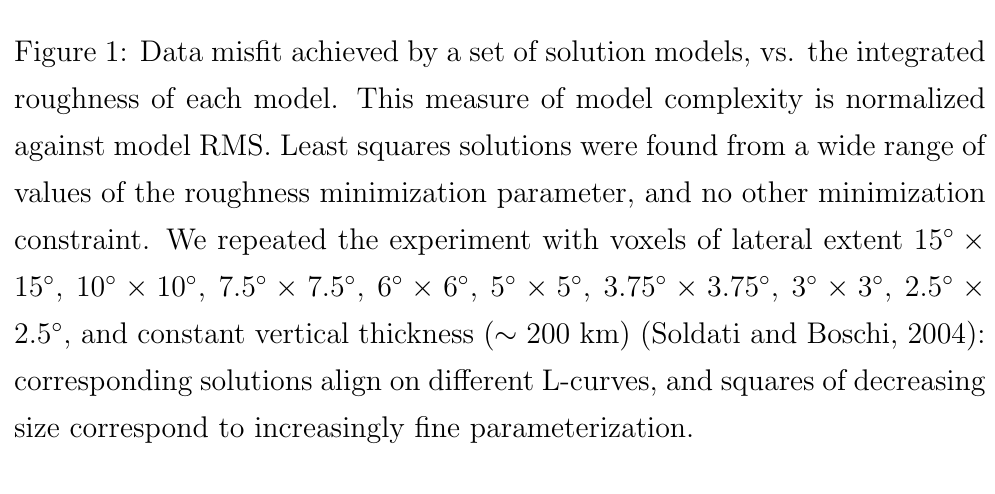
Figure 2: (Top) 24 , 840 × 24 , 840 (5 ◦ -voxel grid) resolution matrix R for the chosen regularization scheme, averaged (Boschi, 2003) so that it can be plotted in this limited space; here, vertical tradeoffs are most evident. (Bottom) Zooms on R , not averaged, at two selected layers (left: mid mantle at ∼ 1300 km depth; right: lower mantle at ∼ 2600 km).